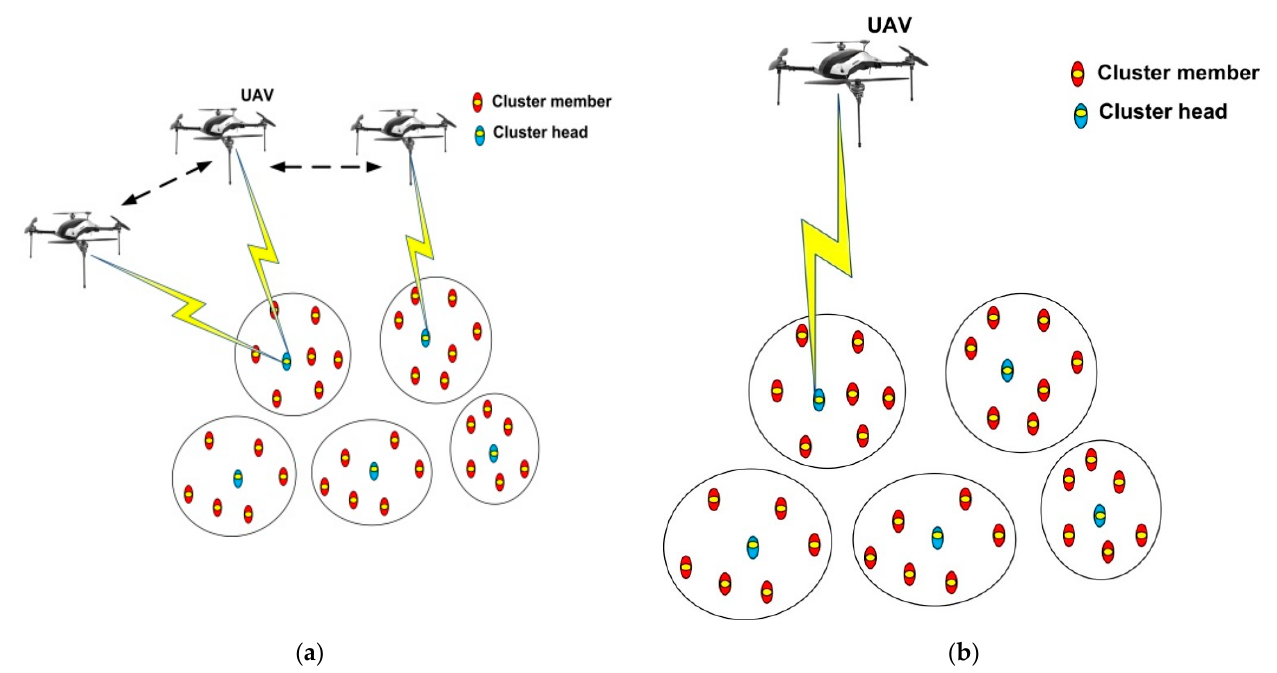
Figure 2. Data collection models in UWSNs: ( a ) data gathering while flying and ( b ) data gathering while